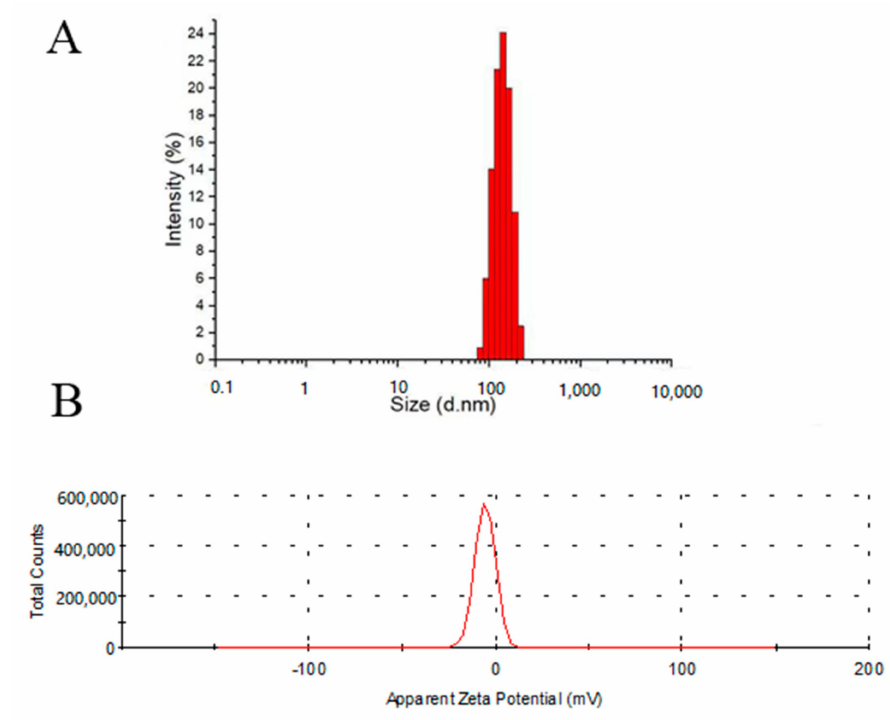
Figure 3. Size distribution ( A ) and zeta potential ( B ) of P1.